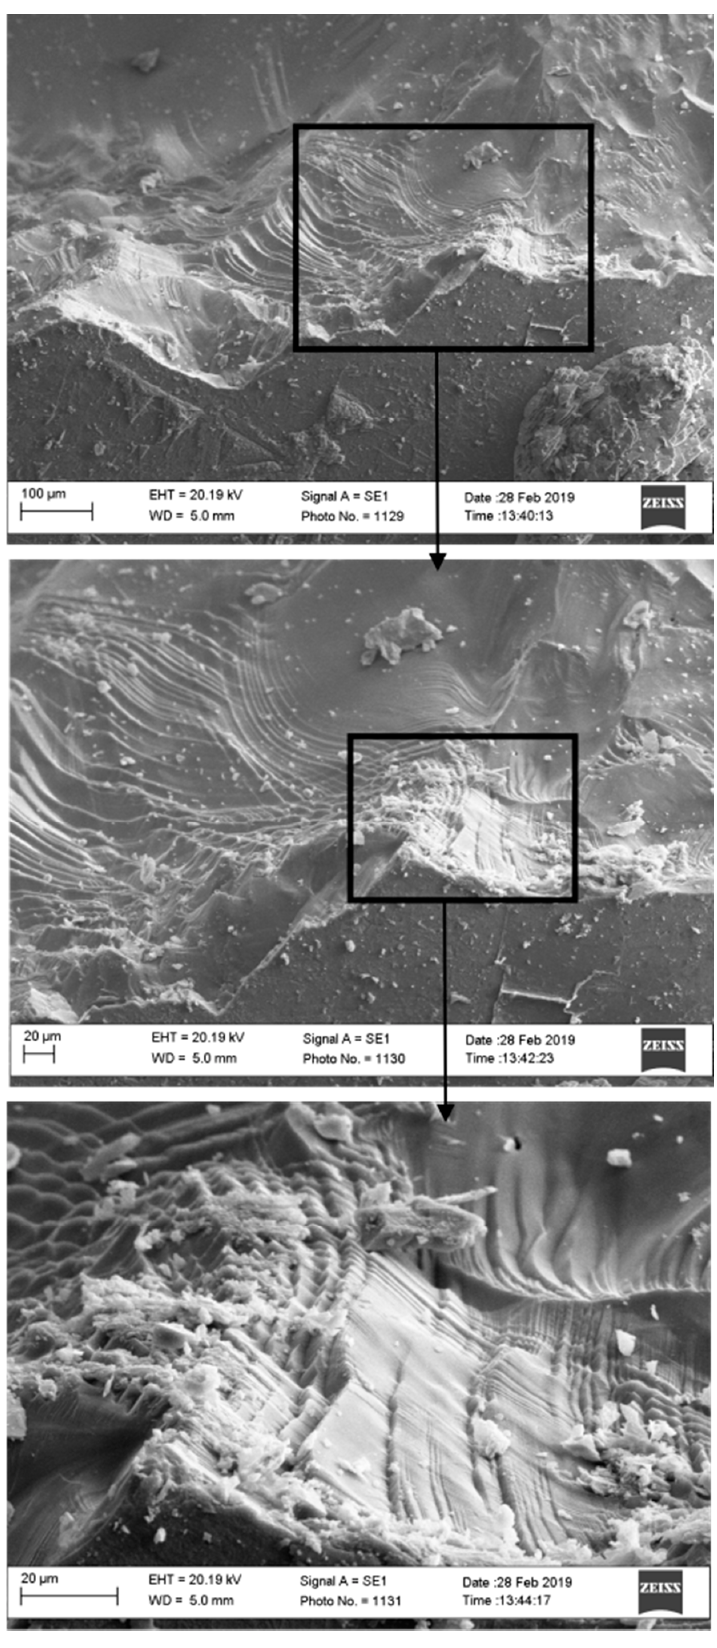
Figure 5. Sawtooth forms generated by the combination of two conchoidal fractures on the surface of the quartz granules; stress rate: 0.5 MPa/s.